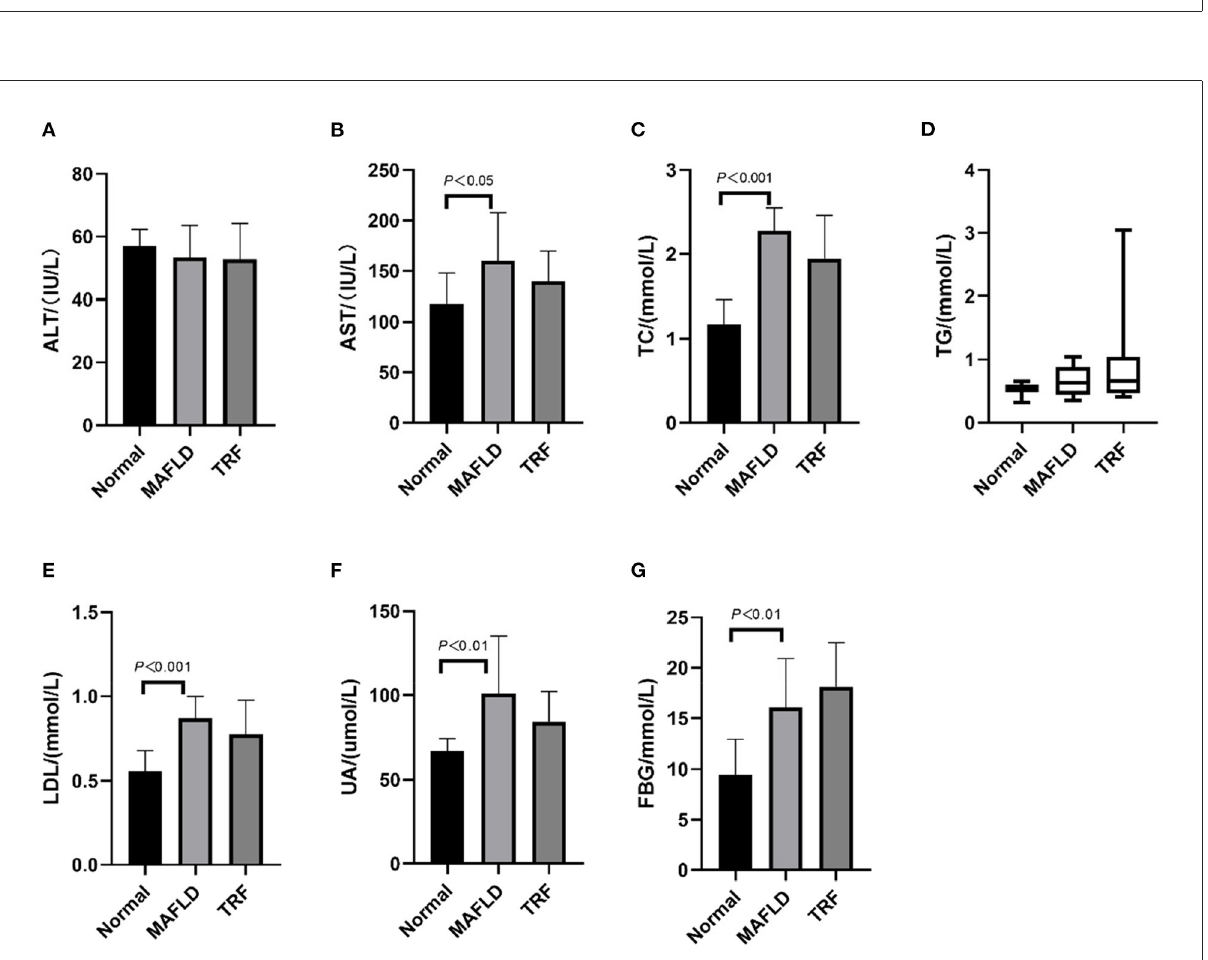
FIGURE3 Serum indexes. (A) Alanine transaminase; (B) aspartate aminotransferase; (C) total cholesterol; (D) triglycerides; (E) low-density lipoprotein; (F) uric acid; (G) fasting blood glucose. The data are presented as means ± SD or percentile. Normal, rat fed a normal diet ad libitum ; MAFLD (metabolic associated fatty liver disease), rat fed a high-fat diet ad libitum ; TRF (time-restricted feeding), fed high-fat diet (60 kcal% fat) strictly only between 16:00 and 22:00 every